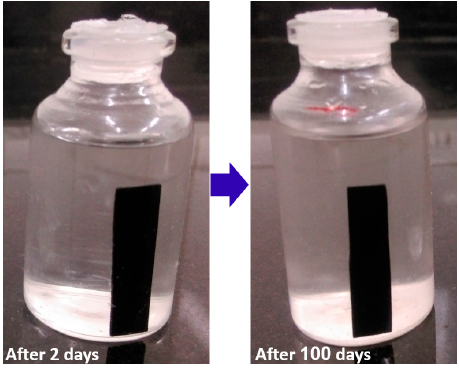
Figure 7. Turbidness of seawater after 100 days at temperature 45 °C due to extraction of soluble compounds from GFRP coupons deposited in water.